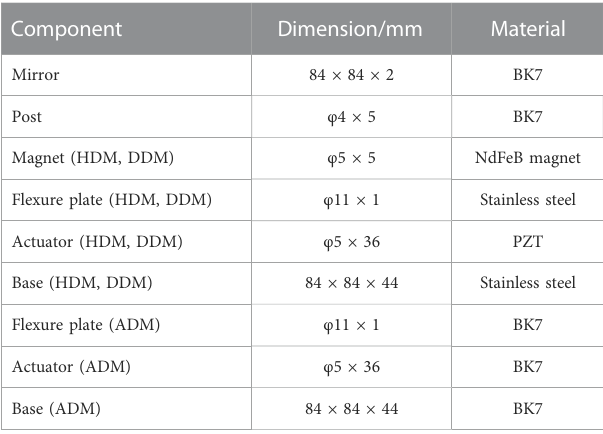
TABLE 1 Structural parameters of the DM